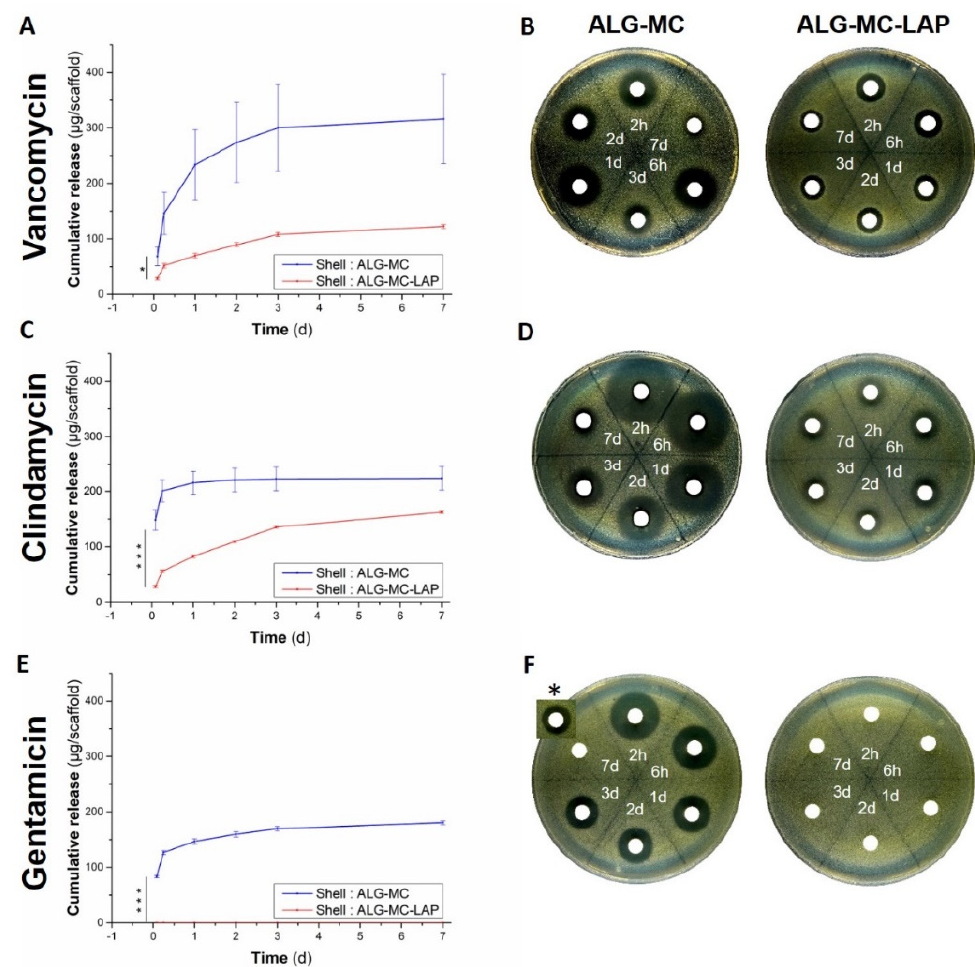
Figure 6. CEC of antibiotics from C/S scaffolds; impact of shell biomaterial ink composition. Cumulative CEC release of antibiotics loaded in ALG-MC and ALG-MC-LAP C/S scaffolds (printed with 200/840 C/S needles), quantified by agar diffusion assay (using S. aureus strain; A , C , E ) over a period of 7 d. Statistical analysis performed only on burst release, i.e., release of antibiotics at 2 h ( n = 3; * p < 0.05; *** p < 0.001). Representative images of ZOI formed on the agar plate when release solutions were added to sample carriers ( B , D , F ). A cropped image of ZOI of d 7 release sample of gentamicin was performed on a different agar plate and is added onto the ZOI of remaining samples, * in ( F ). Release solutions collected from ALG-MC scaffolds at initial time points (2 h and 6 h) developed large ZOI, indicating a burst release of the loaded antibiotic. For release